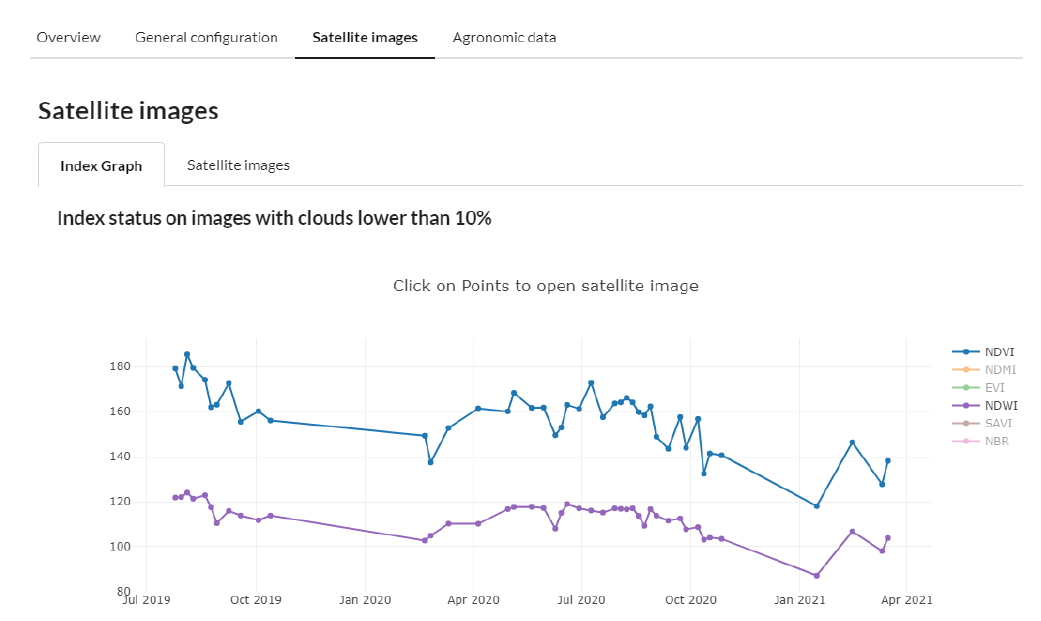
Figure 12. Use of vegetation (NDVI) and water (NDWI) indexes for satellite monitoring of crop condition. To improve the recommendation in choosing of the best varietal group in a selected area, the advice to implement or not a specific variety in the chosen site has been added in the viewer, based on the cooling needs of each group in the area, see Figure 13.